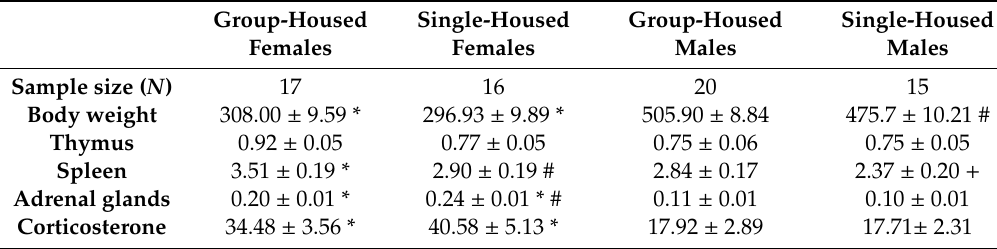
Table 1. Body weight (g), relative weights of thymus, spleen, and adrenal glands (mg / g BW), and serum corticosterone concentration (ng / mL) in control and socially isolated